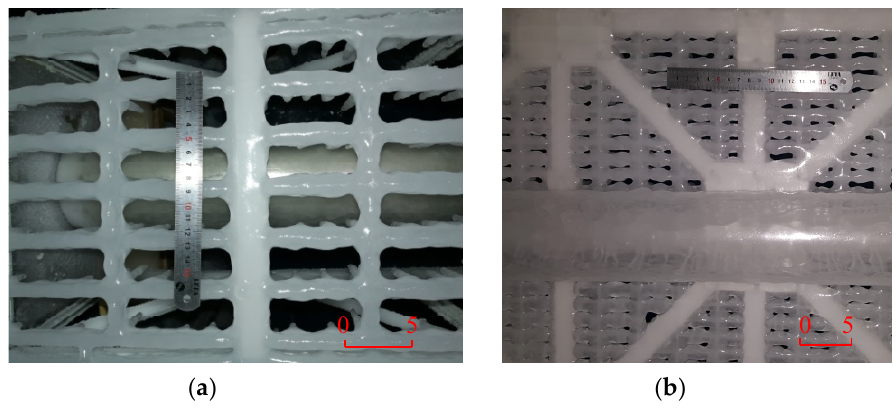
Figure 21. Ice accretion of grate plate: ( a ) girder A and ( b ) girder B.